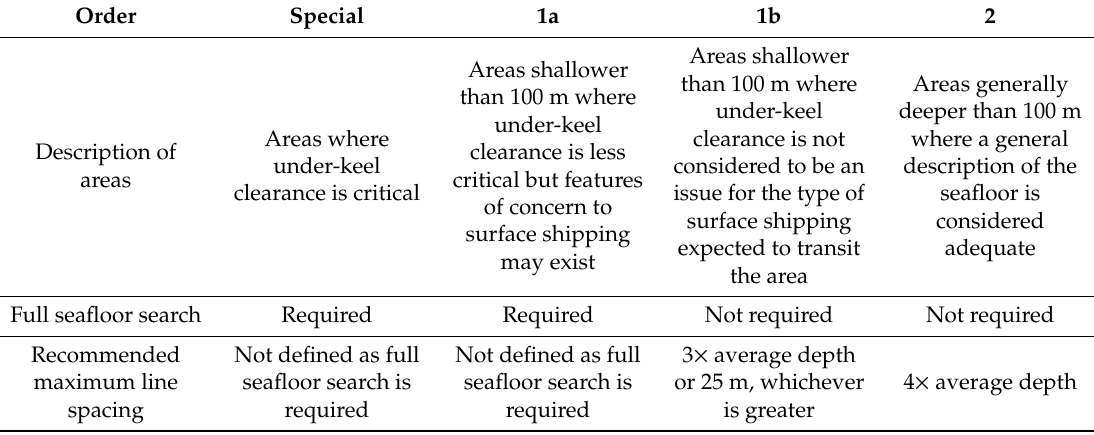
Table 1. List of selected requirements for hydrographic measurements